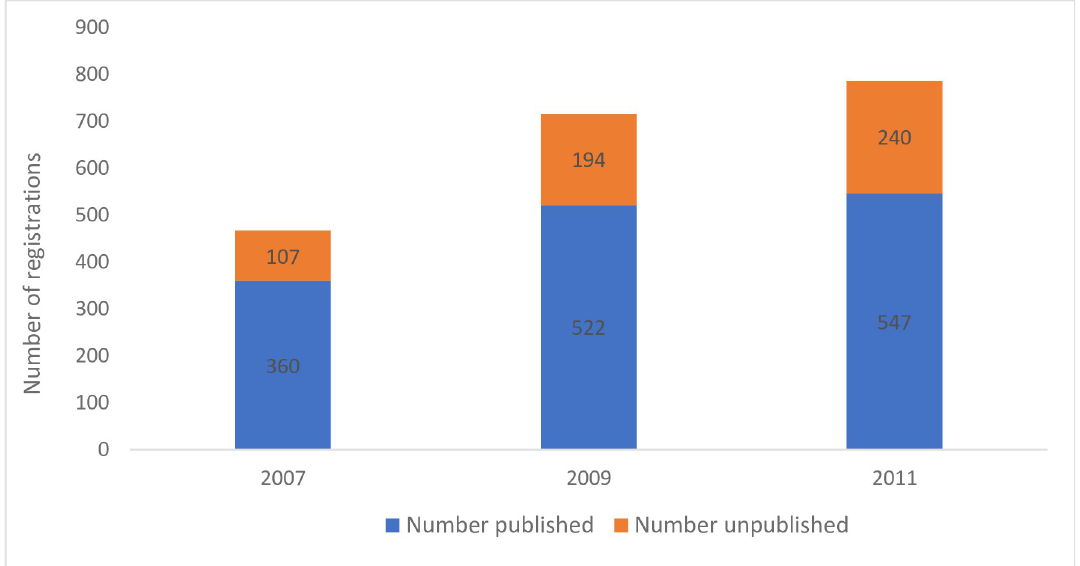
Fig 2. Publication of ANTCTR registrations for the years 2007, 2009, and 2011 (n = 1,970).